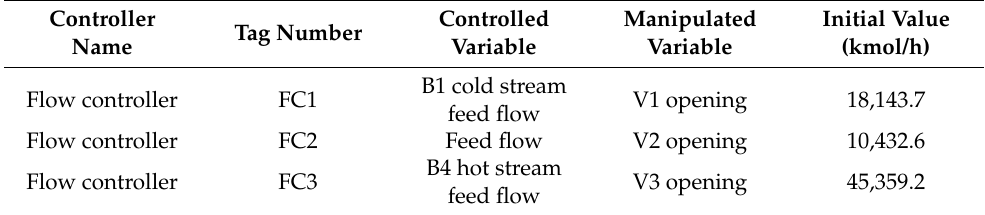
Table 1. Controller